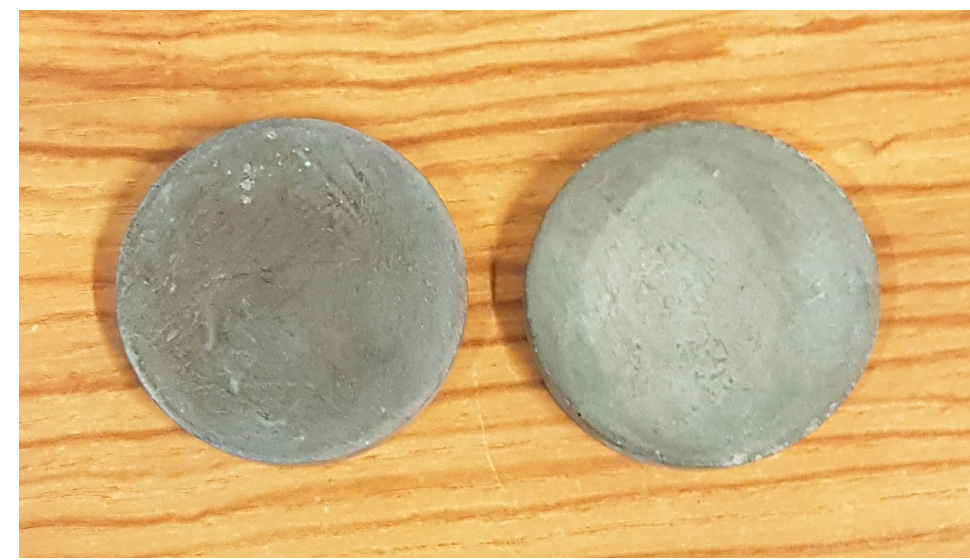
Figure 13. An example of a prepared round samples subjected to thermal conductivity testing.